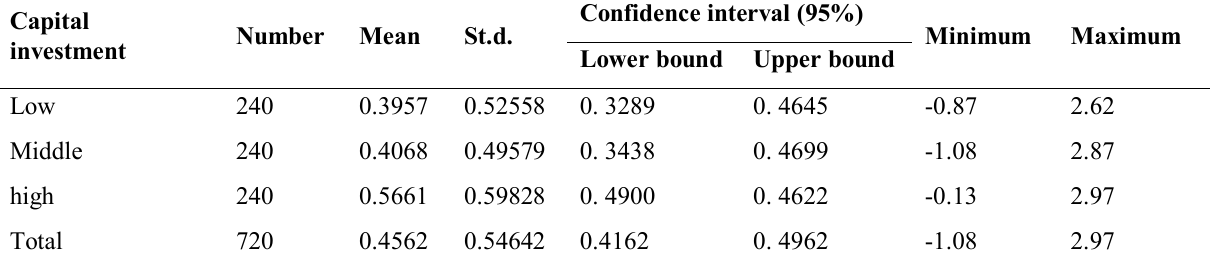
Table 7- descriptive Statistics of variables, according to the quartiles of